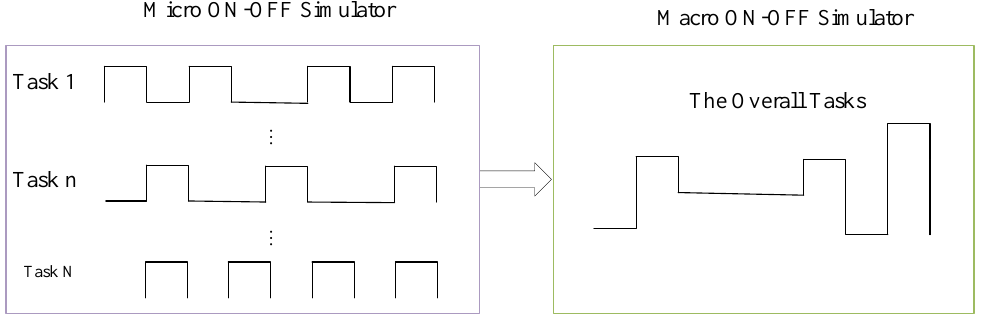
Figure 2. The ON/OFF Simulator